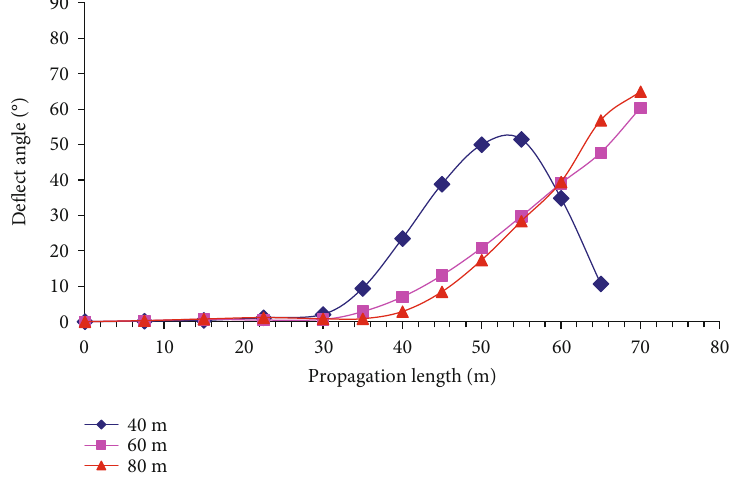
Figure 17: Variation in the de fl ection angle as a function of time under di ff erent lateral